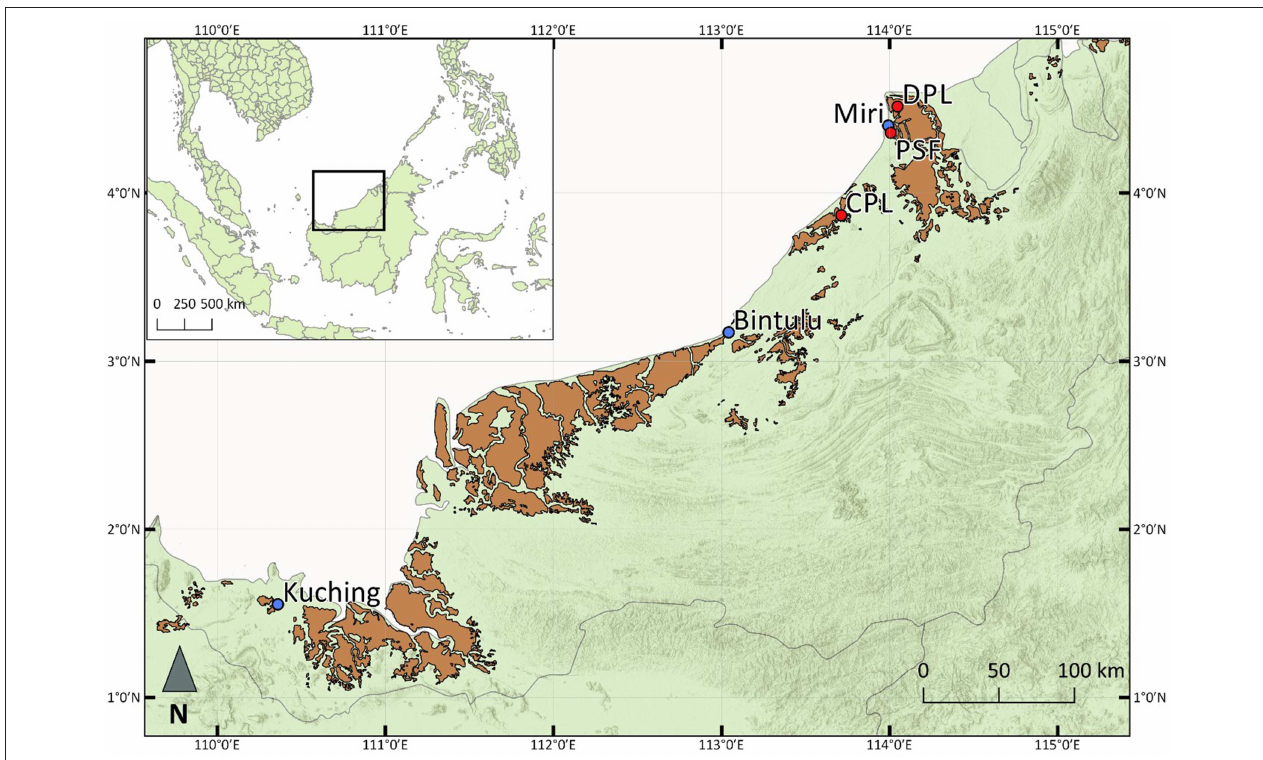
FIGURE 1 | Map showing the geographical location of Sarawak, Malaysian Borneo (inner box), within Southeast Asia, annotated with the main settlements (blue circles), and three peat swamp sites (red circles) from which cores were extracted: DPL (Deforested Peatland), PSF (Peat Swamp Fragment), and CPL (Converted Peatland). Sarawak State Boundary is demarked by a gray line; peatland areas by brown shading [courtesy of Wetlands International: “Malaysia peat lands,” accessed through Global Forest Watch (www.globalforestwatch.org)